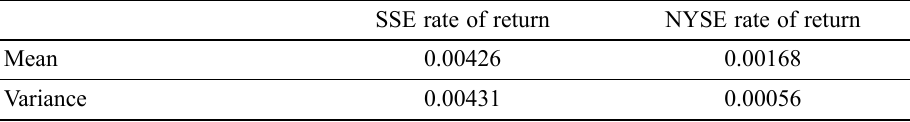
Table 2. Means and variances of the rate of return